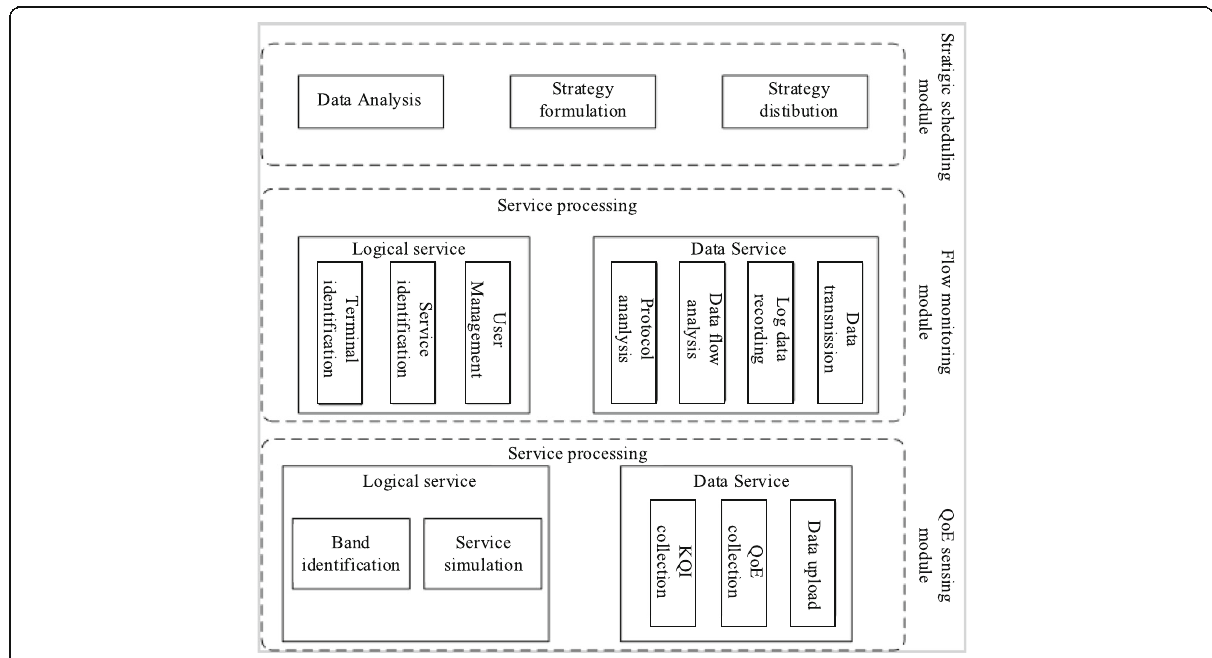
Fig. 2 Functional framework of the